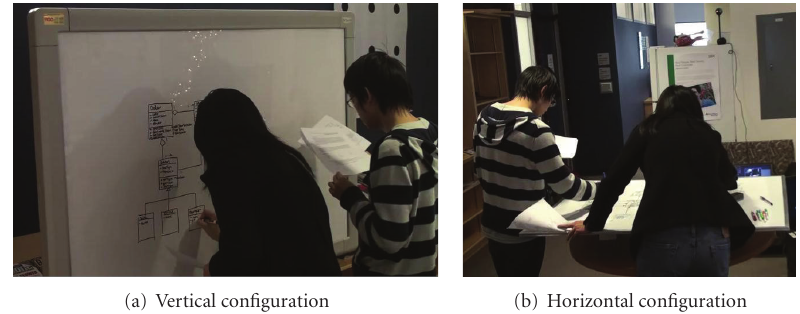
Figure 1: Participants working in vertical and horizontal configurations.